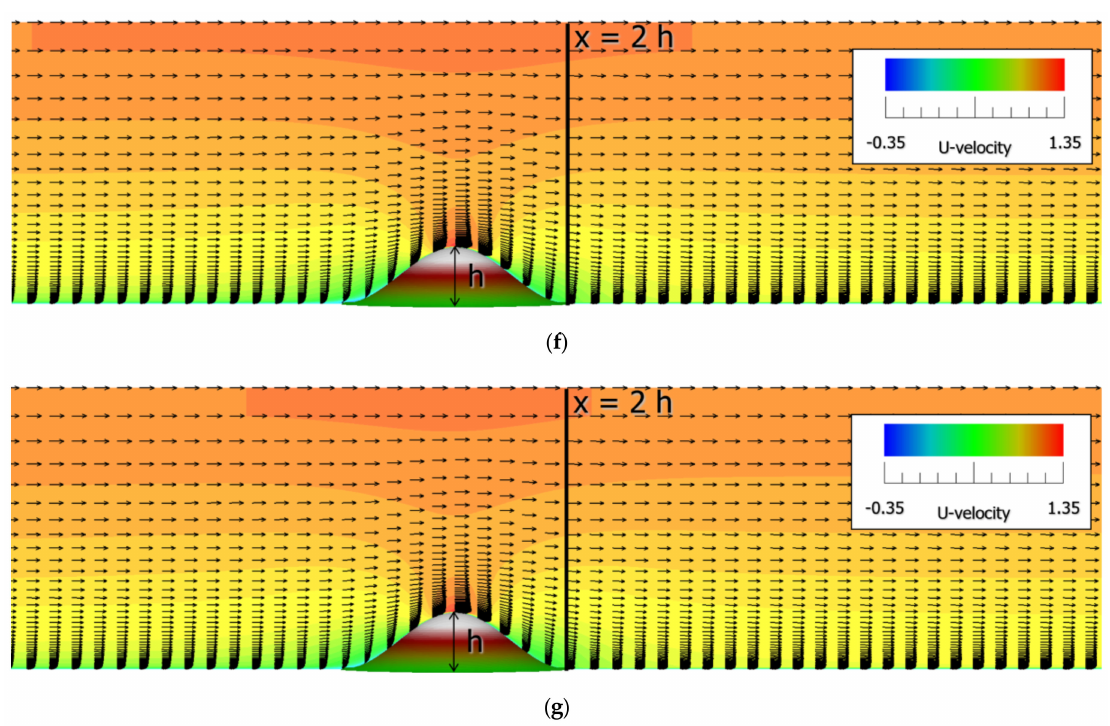
Figure 10. Comparison of flow patterns for a time-averaged flow field under various stable conditions in the steep hill scenario. ( a ) Ri = 0.0 (neutral flow); ( b ) Ri = 0.2 (stable stratified flow); ( c ) Ri = 0.4 (stable stratified flow); ( d ) Ri = 0.5 (stable stratified flow); ( e ) Ri = 0.6 (stable stratified flow); ( f ) Ri = 0.8 (stable stratified flow); ( g ) Ri = 1.0 (stable stratified flow).